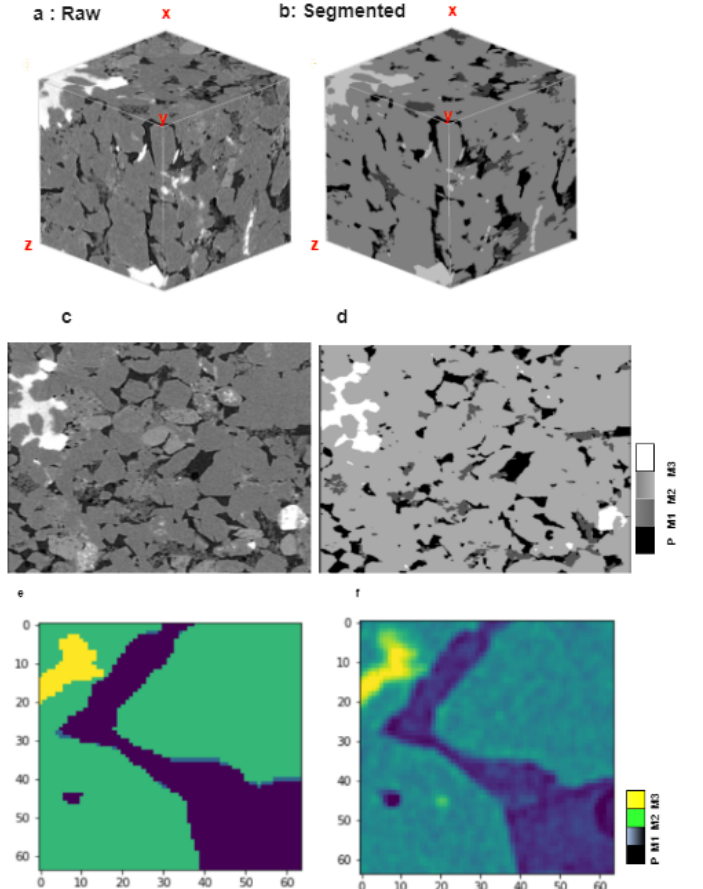
Figure 1. Represents the both 2D and 3D samples and train image/mask of individual slice. ( a ) Rep- resentation of 3D volume raw sample. ( b ) Representation of 3D volume segmented result. ( c ) Repre- sentation of 2D raw sample 512 × 512. ( d ) Representation of 2D segmented result. ( e ) 64 × 64 slice of training image. ( f ) 64 × 64 slice of training mask for model